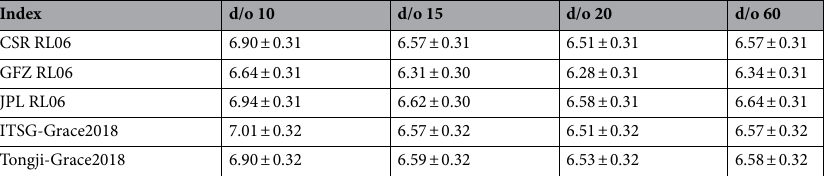
Table 8. The annual amplitude of GMOM change for five GRACE solutions at different truncated degree and orders (d/o) from January 2005 to December 2016 except for the degree-1 and C 20 coefficients [unit: